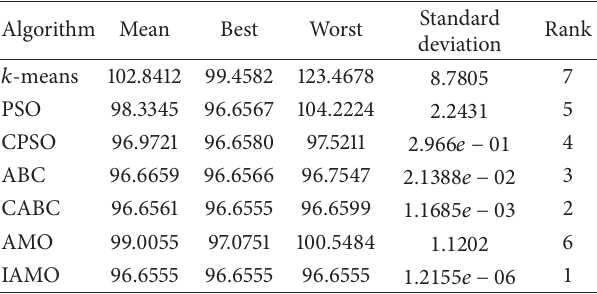
Table 6: Results obtained by the algorithms for 20 different runs on seeds data.